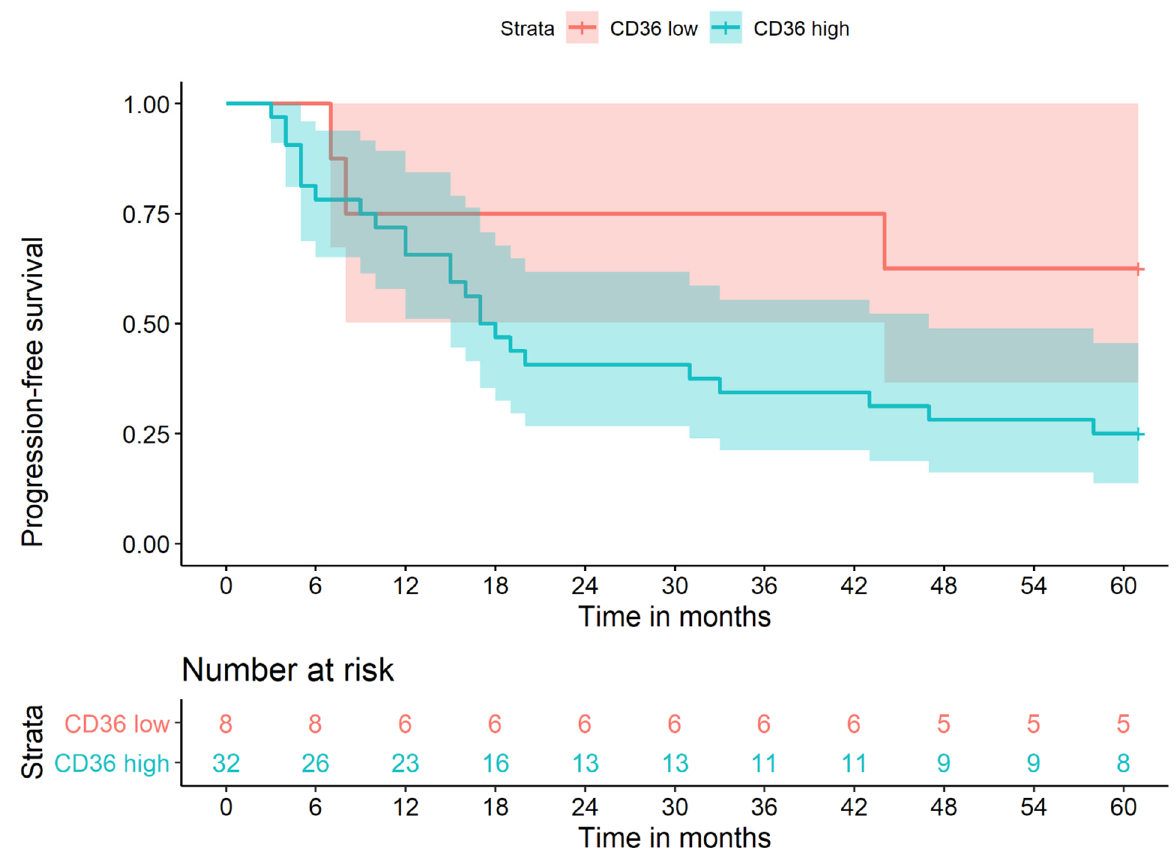
Figure 3. Progression-free survival in all N+ patients, low CD36 vs. high CD36 expression.